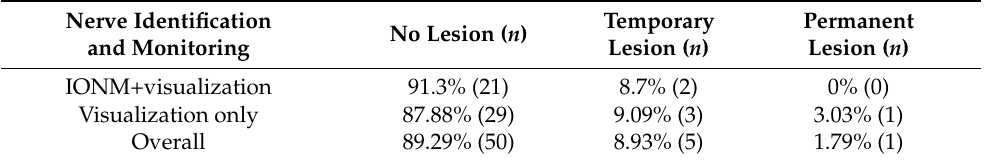
Table 3. Post-operative effects distribution with IONM + visualization and visualization only and the unconditional distribution